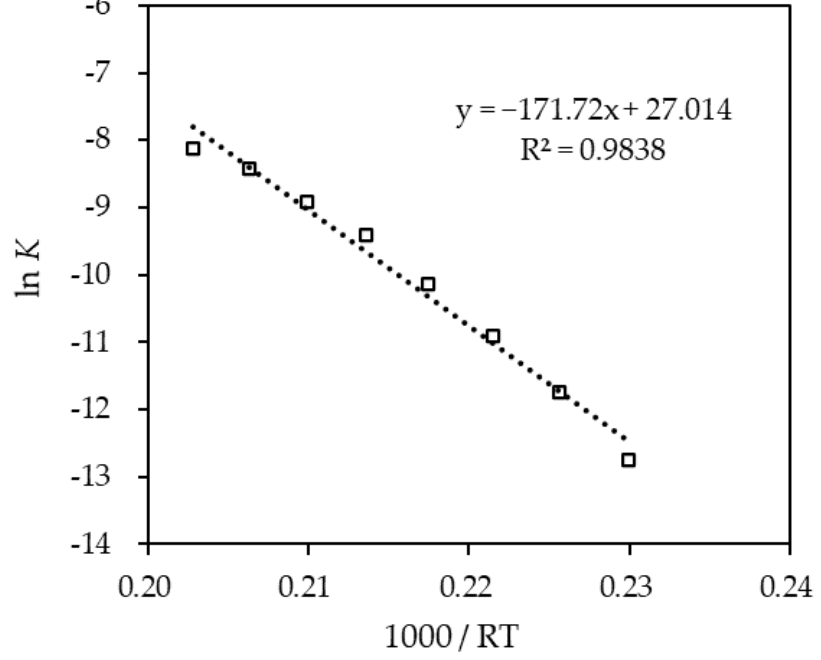
Figure 10. Rate constant ( K ) of the regressed experimental data following the Arrhenius approach over a dehydrogenation temperature range of 250~320 °C for H18-DBT.